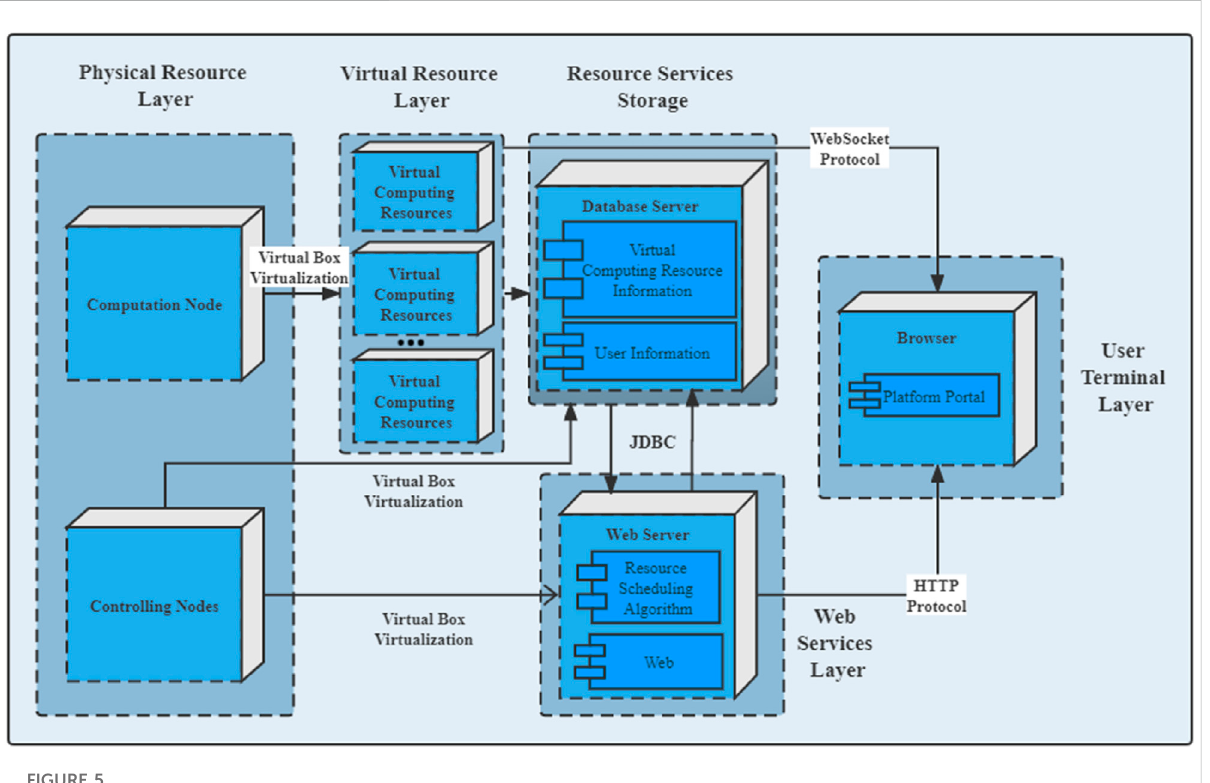
FIGURE 5 Platform deployment fl